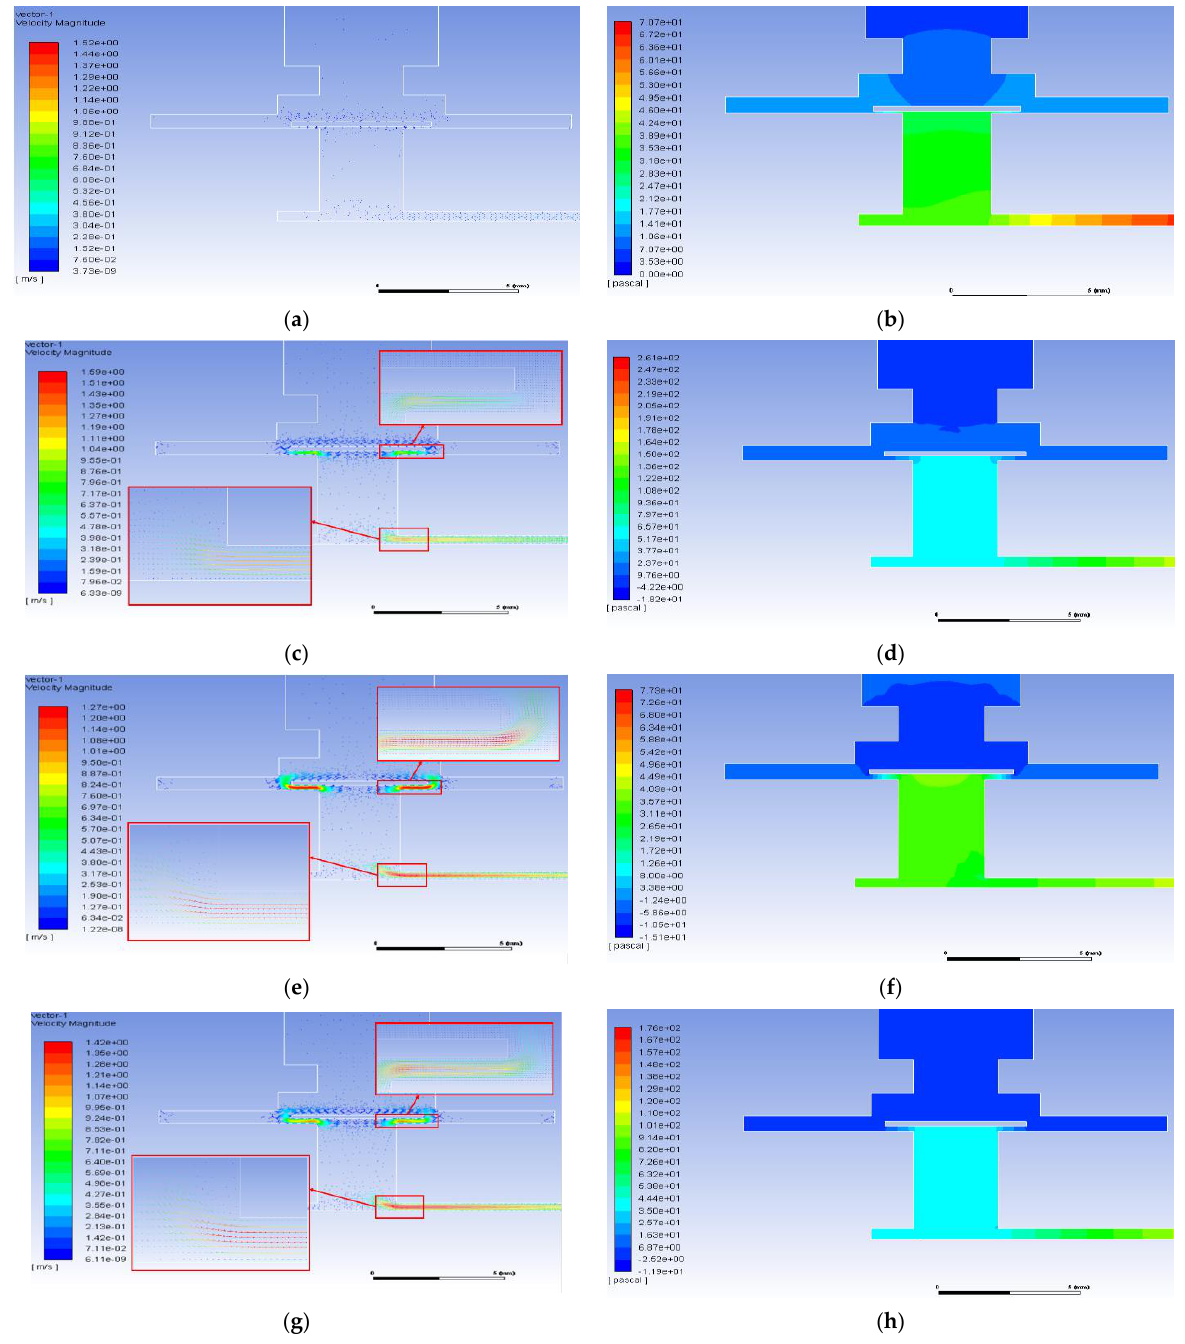
Figure 7. Flow field results at the outlet check valve at a driving frequency of 120 Hz at some typical moments. ( a ) Velocity vector at t = 2 × 10 −4 s; ( b ) Pressure contour at t = 2 × 10 −4 s ; ( c ) Velocity vector at t = 4.16 × 10 −4 s; ( d ) Pressure contour at t = 4.16 × 10 −4 s ; ( e ) Velocity vector at t = 1.04 × 10 −3 s; ( f ) Pressure contour at t = 1.04 × 10 −3 s ; ( g ) Velocity vector at t = 2.08 × 10 −3 s; ( h ) Pressure contour at t = 2.08 × 10 −3 s . Besides flow velocity and chamber pressure, the flow rate and piston movement can of 120 Hz was shown in Figure 8. The latter will be shown in more detail in the next sec- tion.